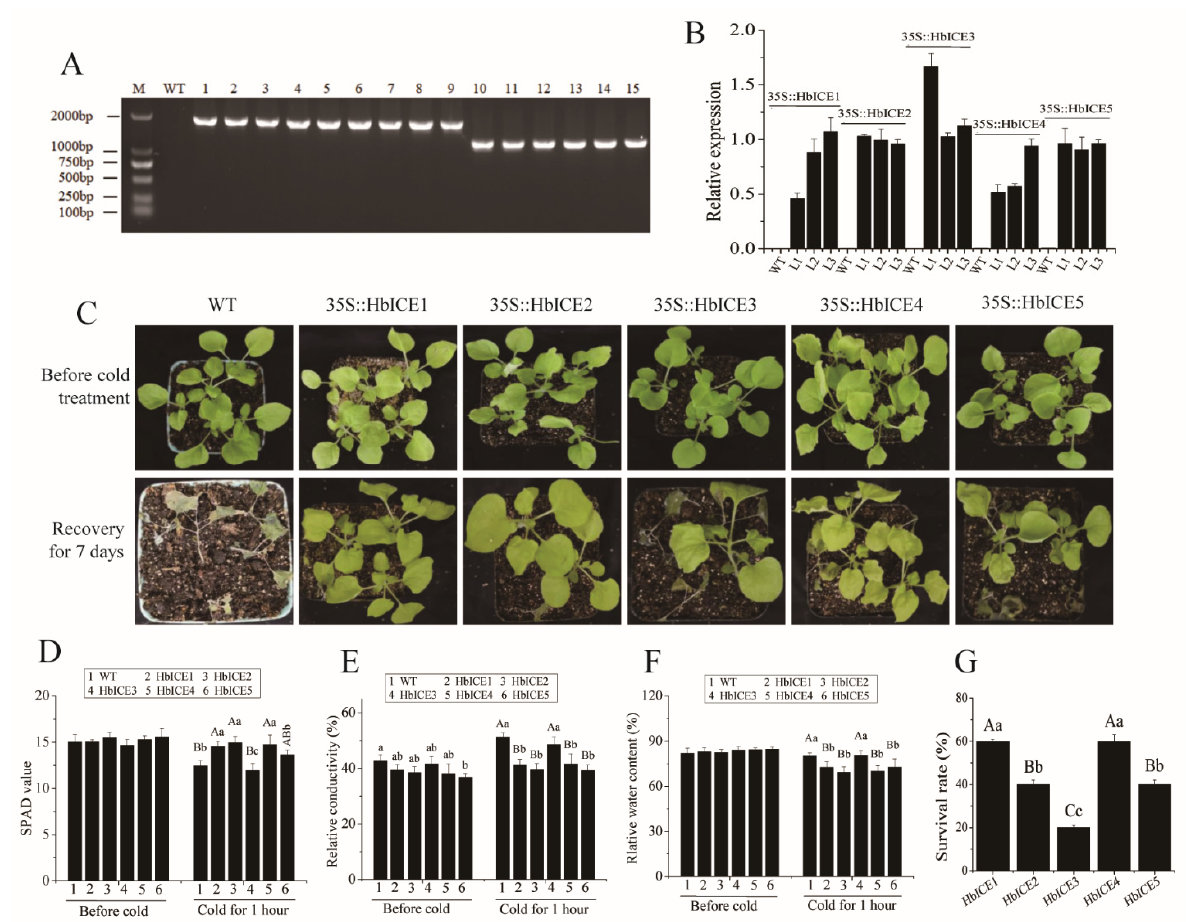
Figure 6. Effect of overexpression of HbICEs on cold tolerance in tobacco. ( A , B ) Identification of HbICEs -overexpressed tobacco lines by genomic RT-PCR ( A ) and qPCR ( B ). M, marker; WT, wild-type; 1–3, HbICE1 -overexpressed transgenic lines; 4–6, HbICE2 - overexpressed transgenic lines; 7–9, HbICE3 -overexpressed transgenic lines; 10–12, HbICE4 -overexpressed transgenic lines; 13–15, HbICE5 -overexpressed transgenic lines. ( C ) The phenotypes of WT and transgenic plants before and after cold treatment. ( D – G ) Analysis of the SPAD value ( D ), relative conductivity ( E ), relative water content ( F ), and survival rate ( G ) in tobacco WT and transgenic plants.